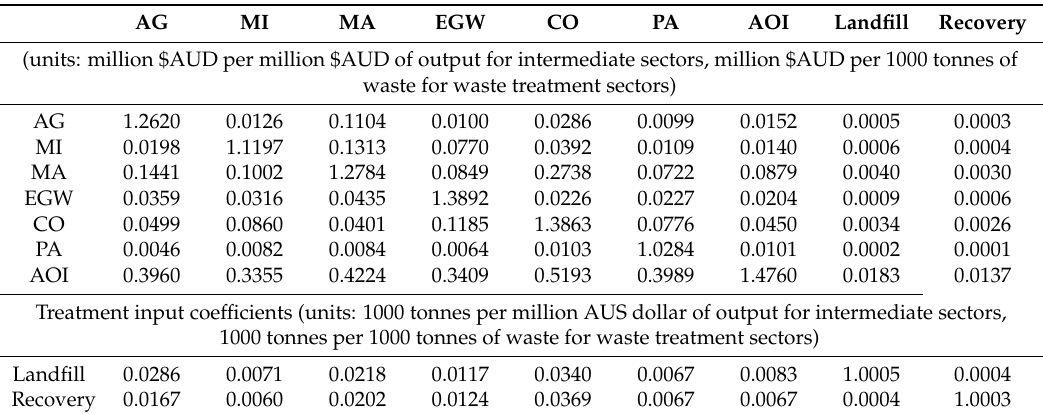
Table 11. The Leontief inverse matrix of the Australian waste input output (WIO) analysis, 2010–2011. AG MI